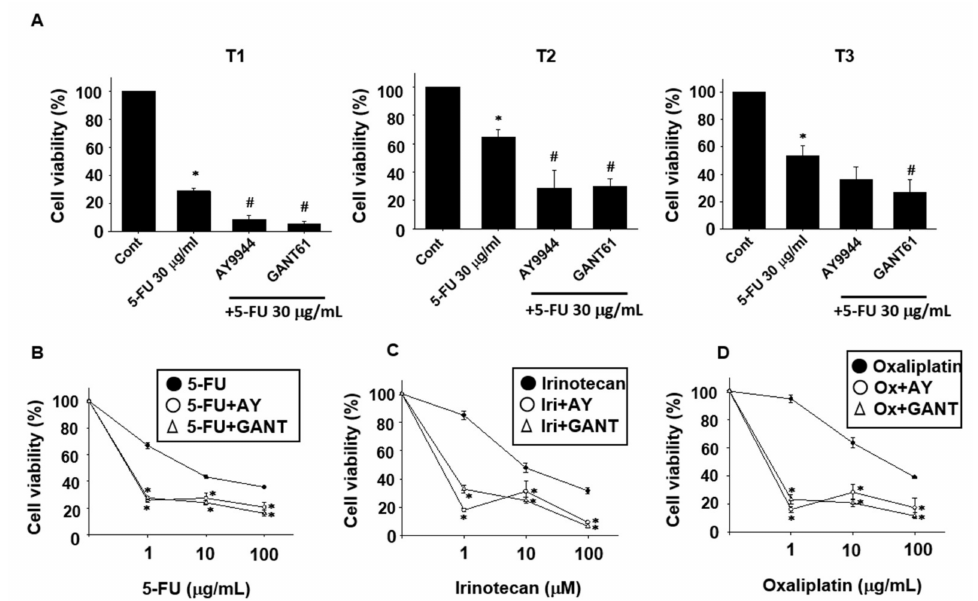
Figure 1. Effects of Hedgehog signal inhibitors on the sensitivity for anti-cancer drugs in tumor ALI organoids. After tumor ALI organoids were seeded into Matrigel, they were treated with 5-FU (30 µ g/mL) in the presence or absence of AY9944 or GANT61 for six days ( A ) ( n = 6 each for three patients (T1, T2, T3)). Cell viability was determined using an alamablue assay and 100% represents cell viability of each control. * p < 0.05 vs. Cont. # p < 0.05 vs. 5-FU. Effects of Hedgehog signal inhibitors on cell death induced by various types of anti-cancer drugs in tumor organoids. After tumor ALI organoids were seeded into Matrigel, they were treated with: 5-FU (1–100 µ g/mL) ( B ); Irinotecan (1–100 µ M) ( C ); or Oxaliplatin (1–100 µ g/mL) ( D ) in the presence or absence of AY9944 (10 µ M) or GANT61 (10 µ M) for six days ( n = 6). Cell viability was determined using an alamablue assay and 100% represents cell viability of each control. * p < 0.05 vs. 5-FU ( B ). * p < 0.05 vs. Irinotecan ( C ). * p < 0.05 vs. Oxaliplatin ( D